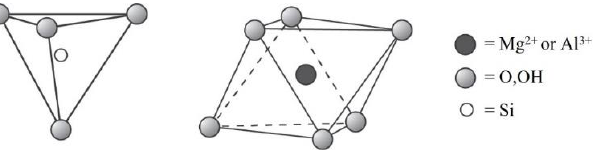
Figure 1. A schematic representation of silica tetrahedron and magnesium or aluminium